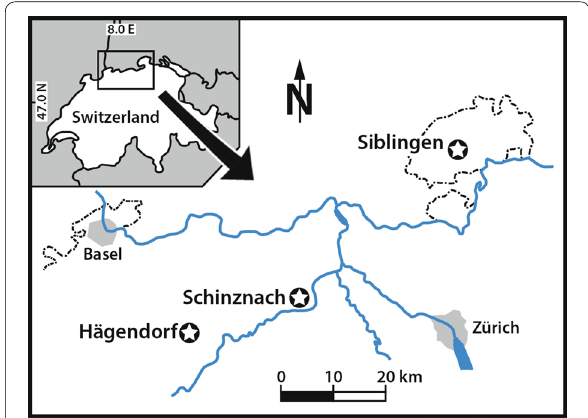
Fig. 1 Location of the sampling sites in the Opalinum Clay Formation of northern Switzerland. The stars indicate the sampling sites. The dotted line is the Swiss border, which partially continues in the Rhine (see small